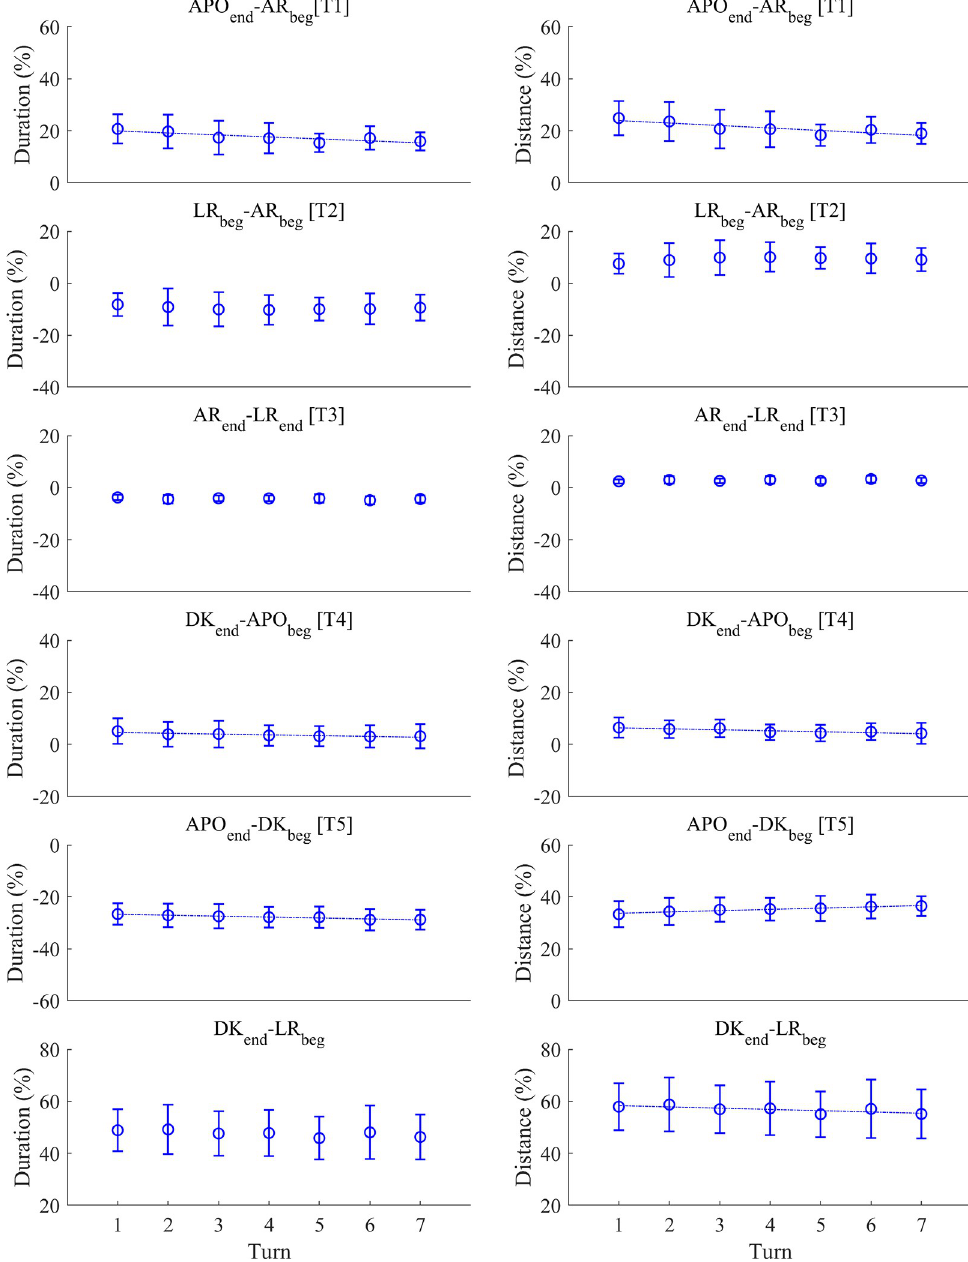
Fig 6. The relative duration and distance in each time gap. Graphs with a linear trend line and a regression equation represent the variables that had a significant lap effect in the linear mixed model analysis.